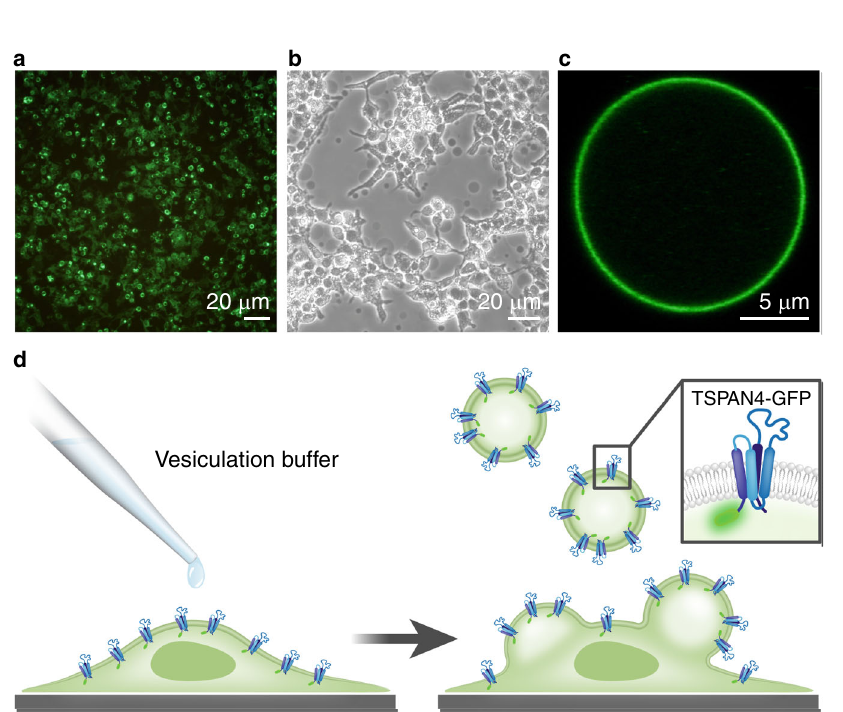
Fig. 2 | Formation of giant plasma-membrane- vesicles (GPMVs) from trans- fected HEK293T cells expressing TSPAN4-GFP. a Fluorescence microscopy image of HEK293T cells expressing TSPAN4-GFP 24h after transfection. b Phase contrast microscopy image of HEK293T cells, expressing TSPAN4-GFP, after treatment with a vesiculation buffer. GPMVs, which appear dark in phase contrast image, can be seen fl oating in the sample or attached to the cells. c Confocal